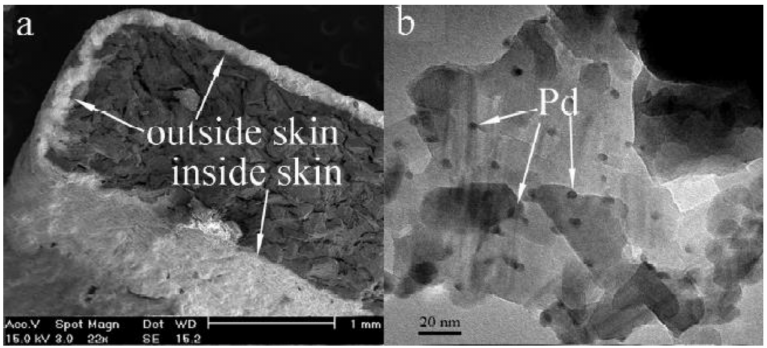
Figure 8. ( a ) SEM image of Pd/ α -Al 2 O 3 @SiC catalyst, ( b ) TEM image of Pd particles on Al 2 O 3 layer of Pd/ α -Al 2 O 3 @SiC catalyst (reproduced with permission from [252]. Copyright 2016, the Royal Society of Chemistry).